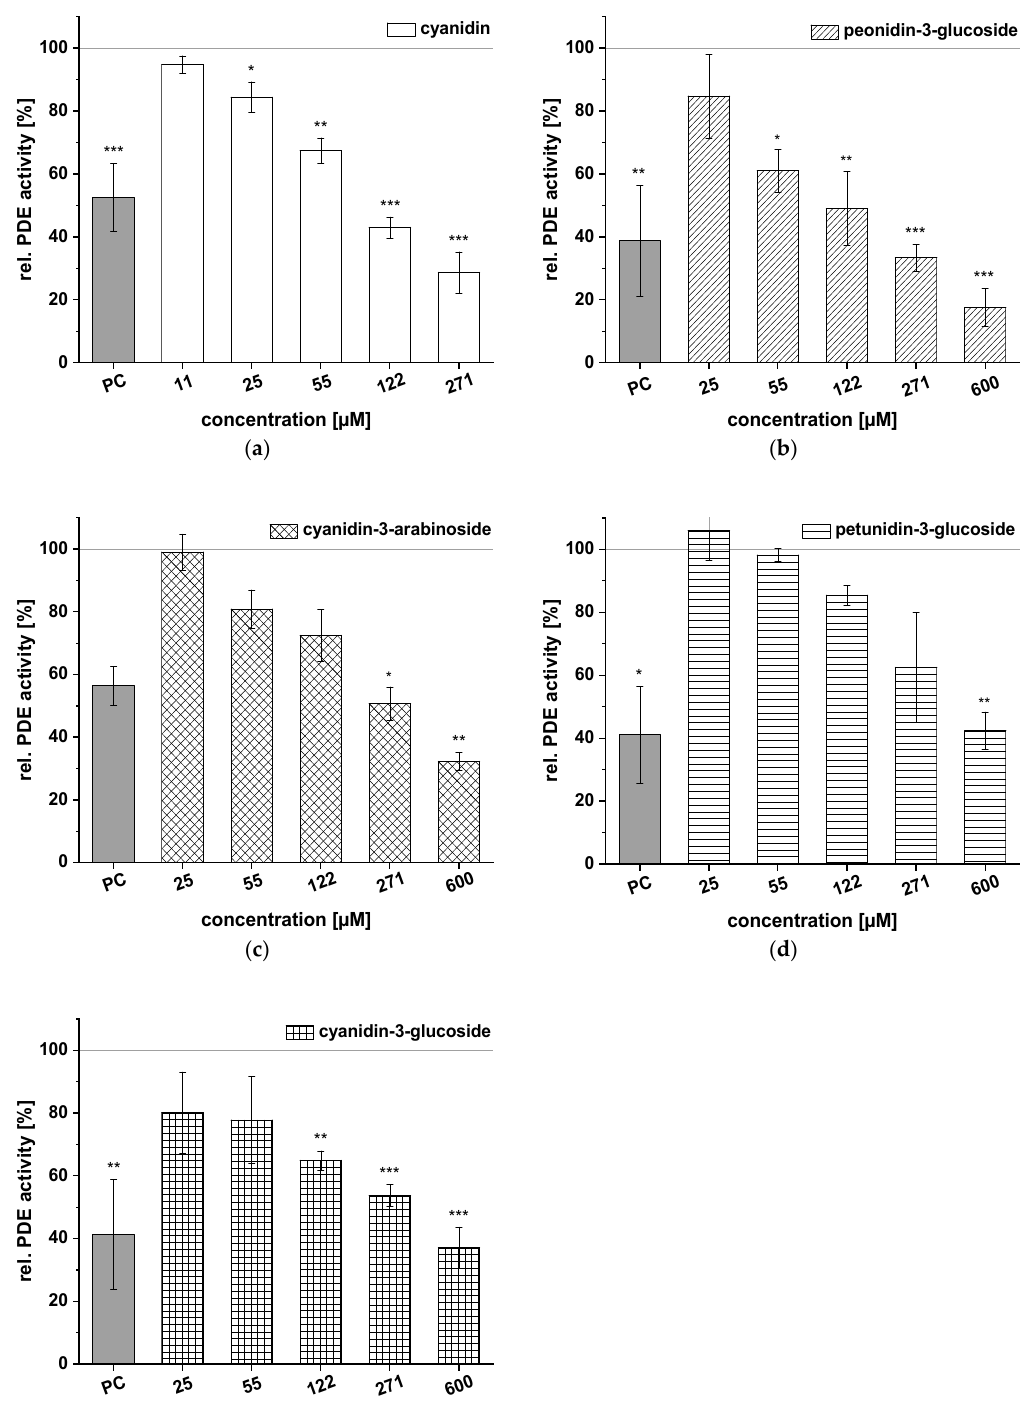
Figure 5. Results for tests of cAMP-specific phosphodiesterase (PDE) activity after incubation with cyanidin ( a ), peonidin-3-glucoside ( b ), cyanidin-3-arabinoside ( c ), petunidin-3-glucoside ( d ), and cyanidin-3-glucoside ( e ). Positive control (PC) was caffeine. Data are expressed as relative (rel.) PDE activity (in percentage of solvent control) as mean ± standard deviation of three or four independent experiments. The significance of differences between sample and solvent control (100%) was assessed using Student’s t -test. * p < 0.05; ** p < 0.01; *** p < 0.001.